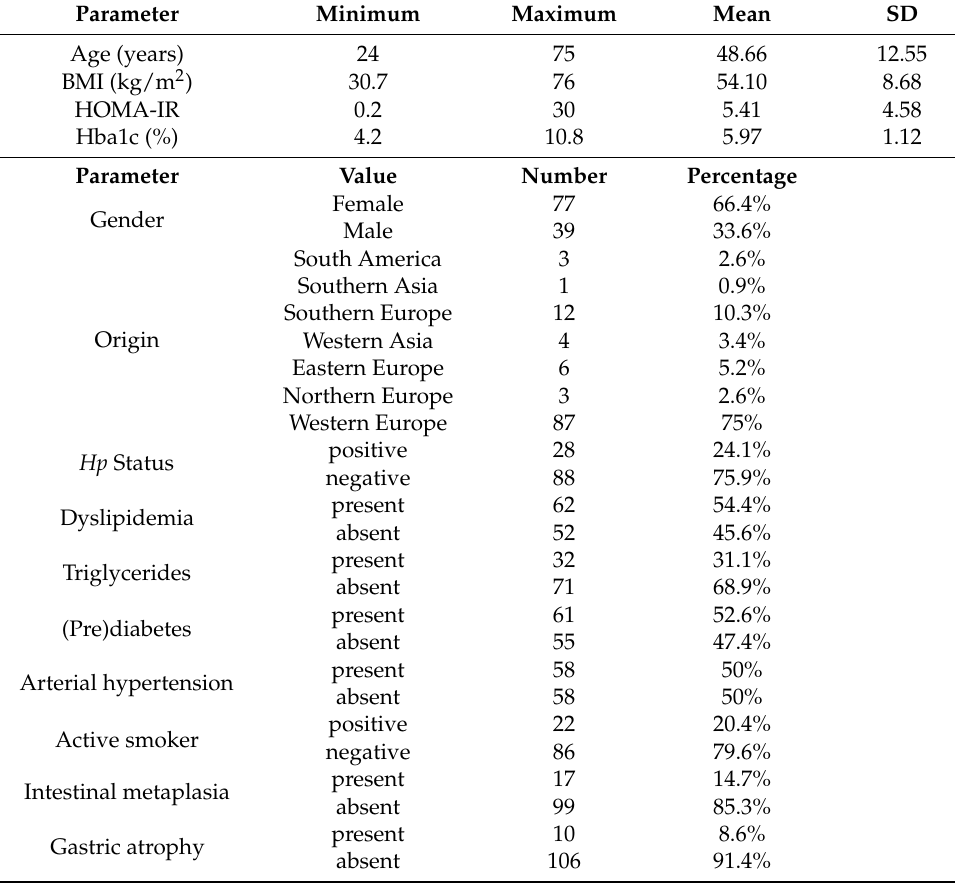
Table 1. Descriptive